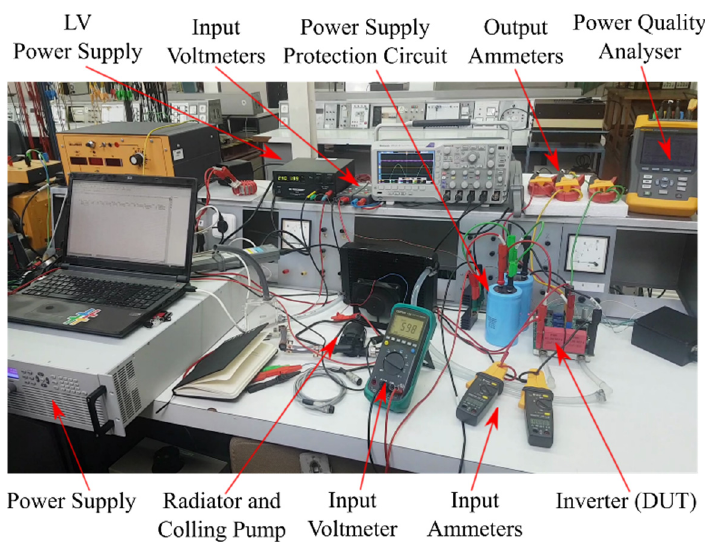
Figure 9. Experimental laboratory setup used to attain the efficiency of the three-Phase SiC Inverter. The 15 kW loads are on the back of the test bench.